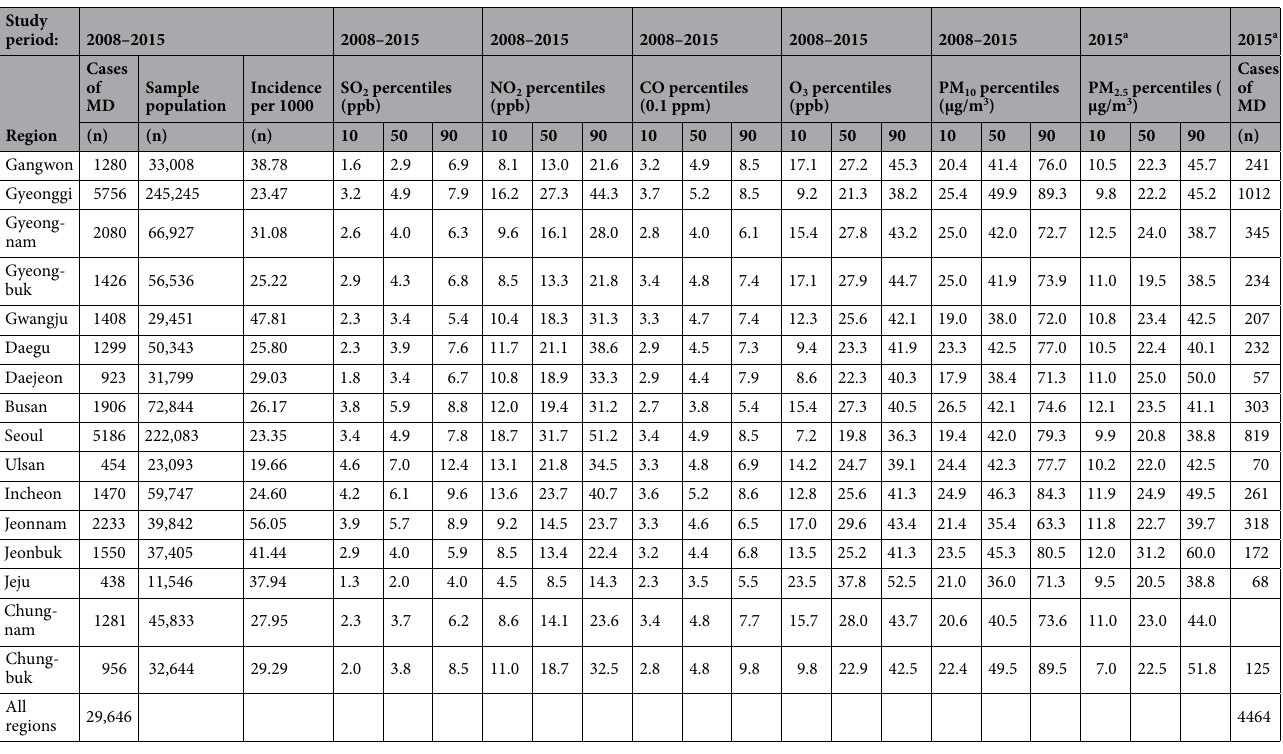
Table 2. Regional Meniere’s disease cases and air pollution distribution in Korea between 2008 and 2015. MD Meniere’s disease. a In analysis for PM 2.5 , Chungnam region with fewer than 20 cases was